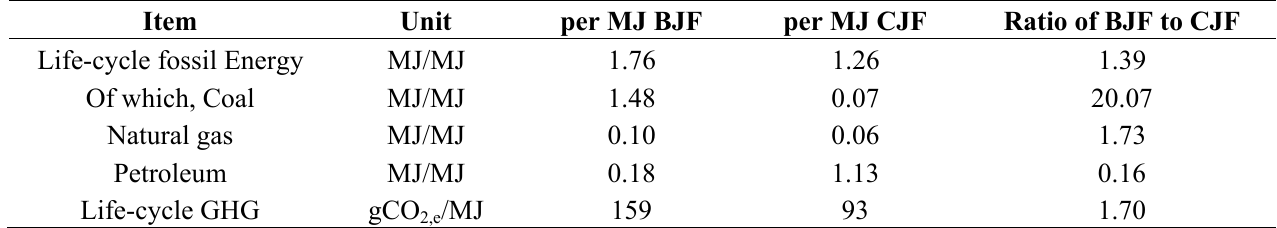
Table 7. Life-cycle fossil energy use and GHG emissions for BJF and